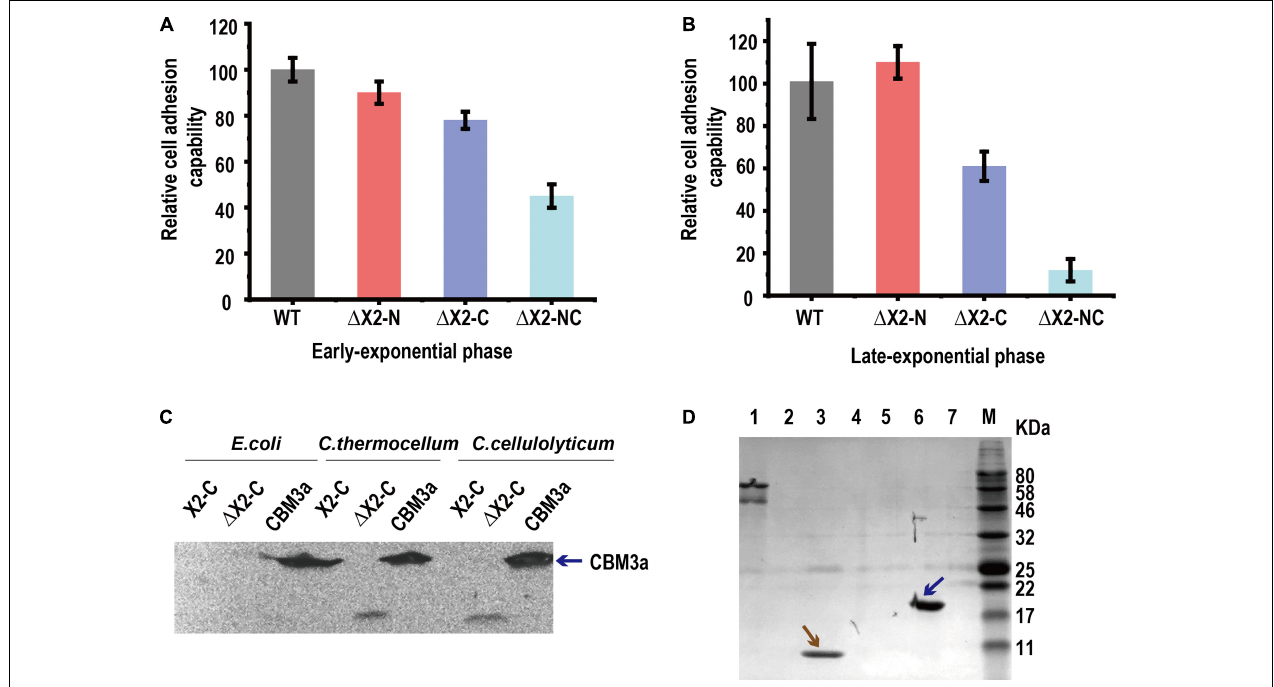
FIGURE 4 | The in vivo function of the X2 module was related to the binding affinity between cells and cellulose. Panels (A,B) , the relative cell adhesion capability between cells and cellulose for each strain in early exponential (A) and late-exponential phase (B) . Data are presented as the mean of three biological replicates and error bars represent SD. (C) The binding of X2-C, (cid:49) X2-C, and CBM3a proteins to the cell surfaces of E. coli , C. thermocellum, or C. cellulolyticum respectively, determined by western blot. CBM3a was detected in all three strains (as blue arrow indicated), indicating it could bind to the cell surface for both Gram-negative and Gram-positive bacteria. The X2-C could not be detected for any of them, indicating it can not directly bind to the cell surface. The weak band of (cid:49) X2-C was detected in C. thermocellum and C. cellulolyticum , indicating it had a weak binding affinity with the cell surface of the Gram-positive bacteria. (D) Binding of X2-C, CBM3a, and BSA protein to crystalline cellulose, determined by SDS-PAGE. The CBM3a protein and the BSA protein were used as the positive and negative control respectively. The CBM3a was detected in the cellulose pellet (as blue arrow indicated) and X2-C was only detected in the supernatant fraction as same as the BSA negative control (as brown arrow indicated), indicating that X2-C can not directly bind to the cellulose. Lane 1, BSA + Cellulose in supernatant fraction; Lane 2, CBM + Cellulose in supernatant fraction; Lane 3, X2-C + Cellulose in supernatant fraction; Lane 4, blank; Lane 5, BSA + Cellulose in cellulose-containing pellet; Lane 6, CBM + Cellulose in cellulose-containing pellet; Lane 7, X2-C + Cellulose in cellulose-containing